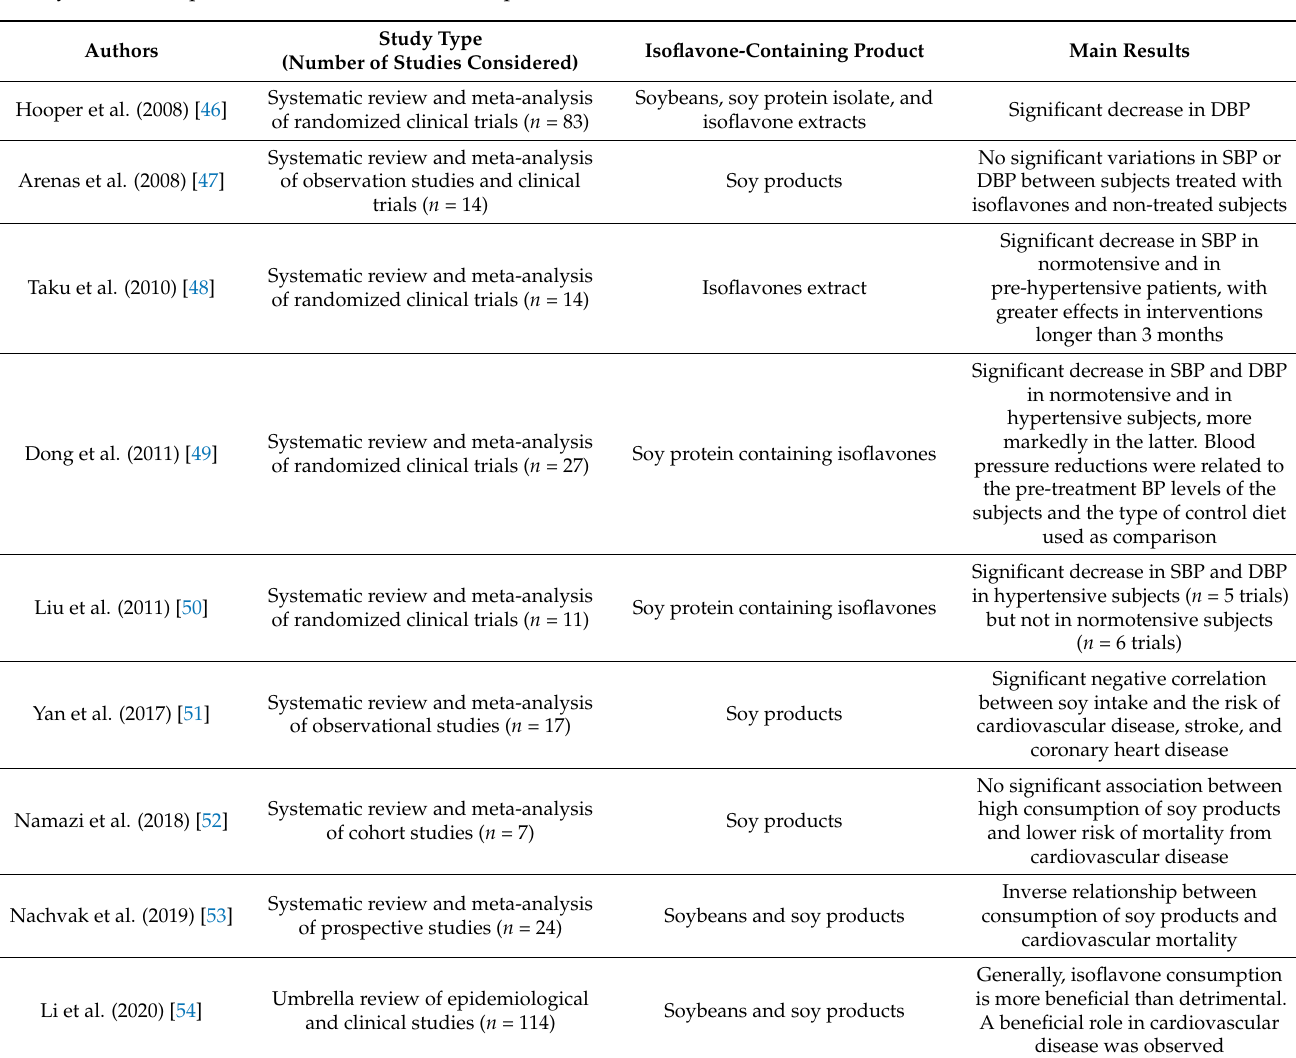
Table 1. Description and main results of the clinical studies on the blood pressure-lowering effects of isoflavones (SBP – systolic blood pressure, DBP – diastolic blood